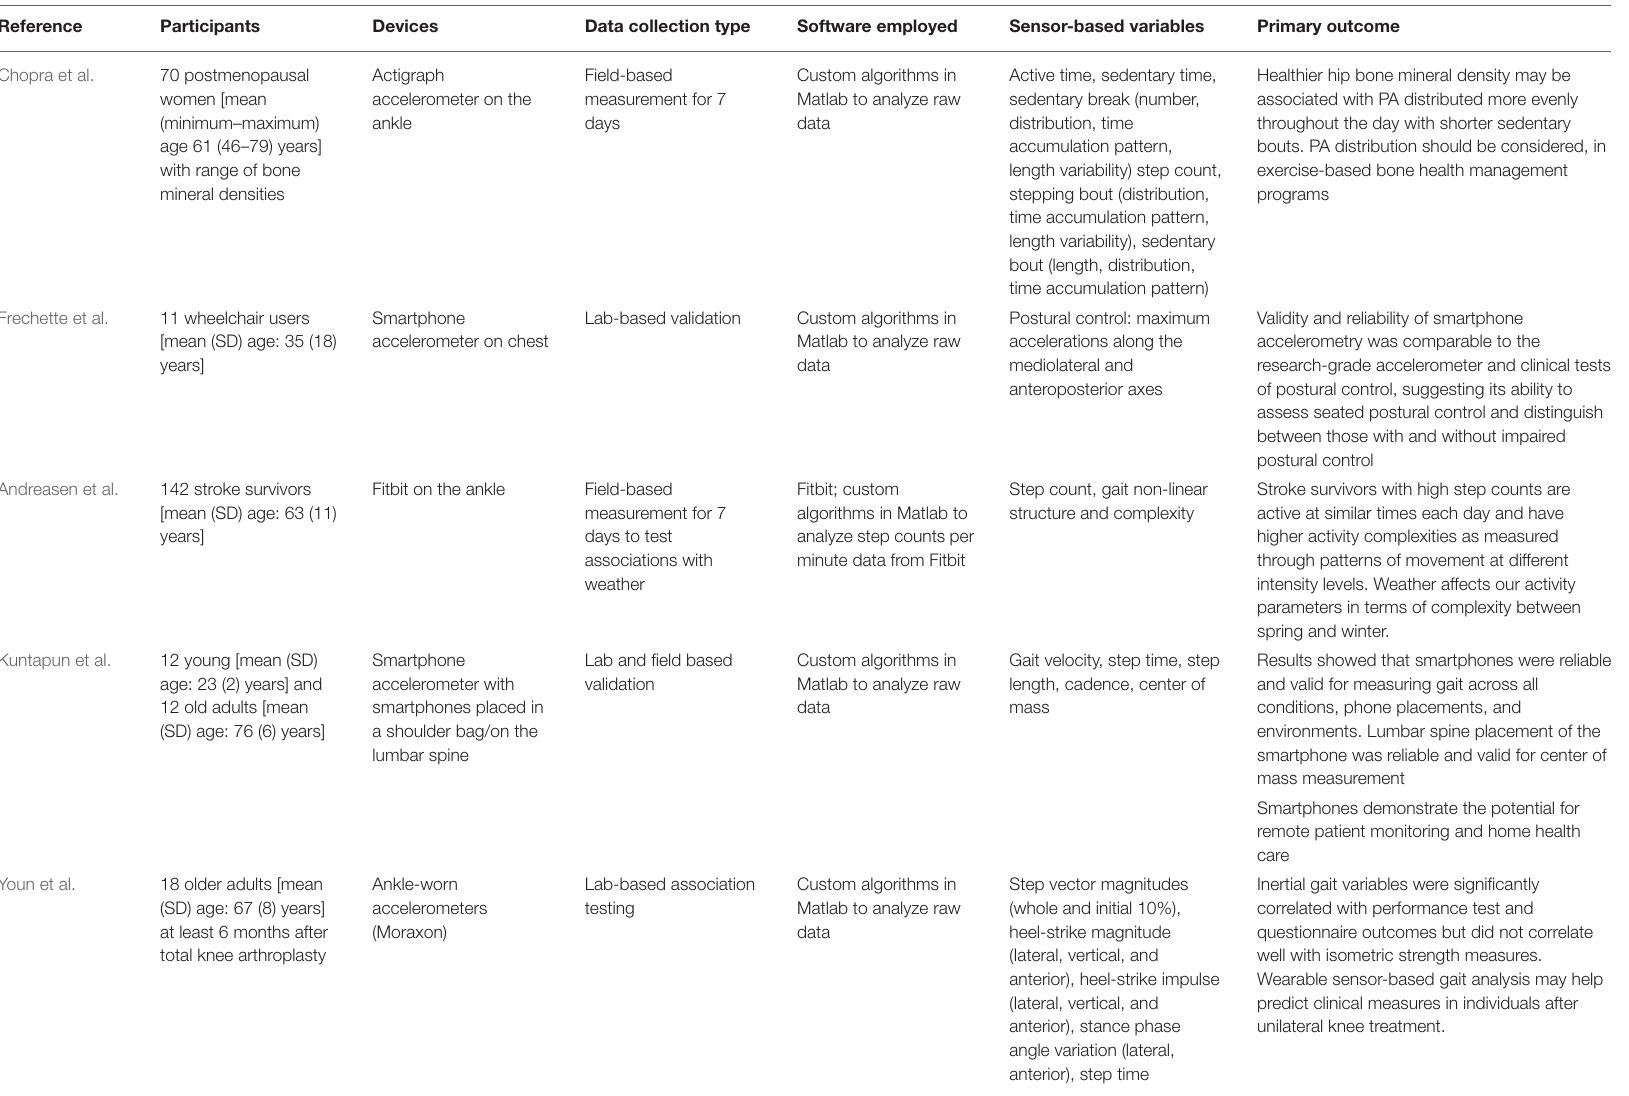
TABLE 1 | Summary of all studies within the Research Topic including participants involved, devices used, data collection type, software employed, sensor-based variables, and primary